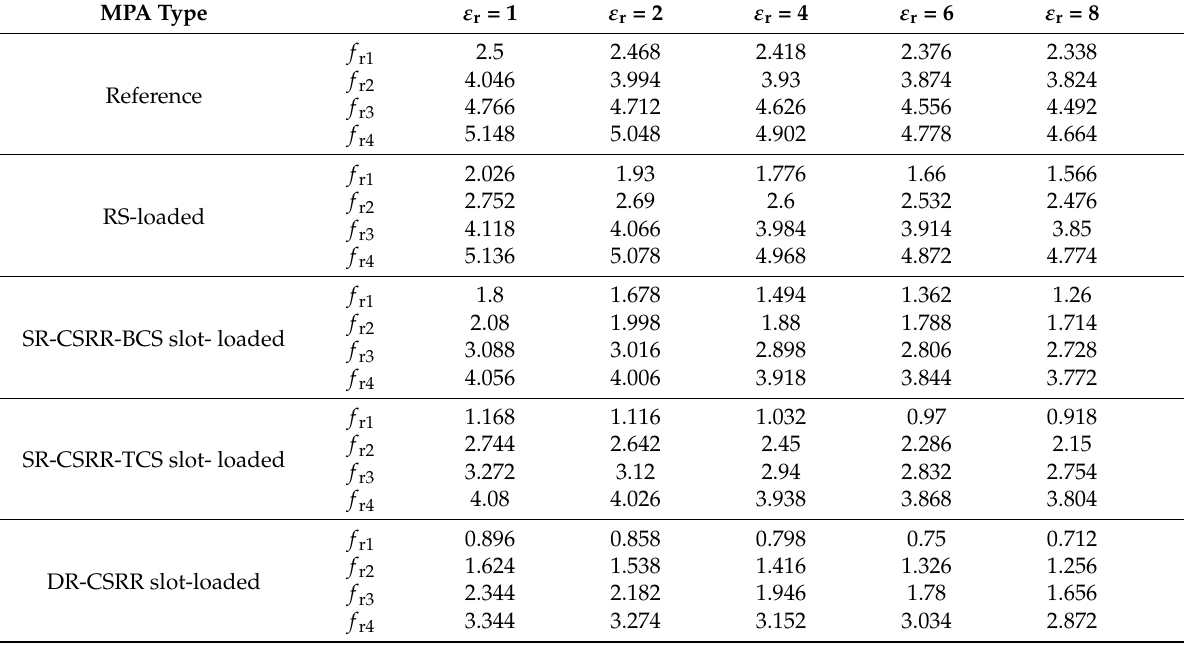
Figure 6. Comparison of the first four resonant frequencies for the reference and four slot ‐ loaded MPAs when varying the relative permittivity of the MUT superstrate from 1 to 10: ( a ) reference